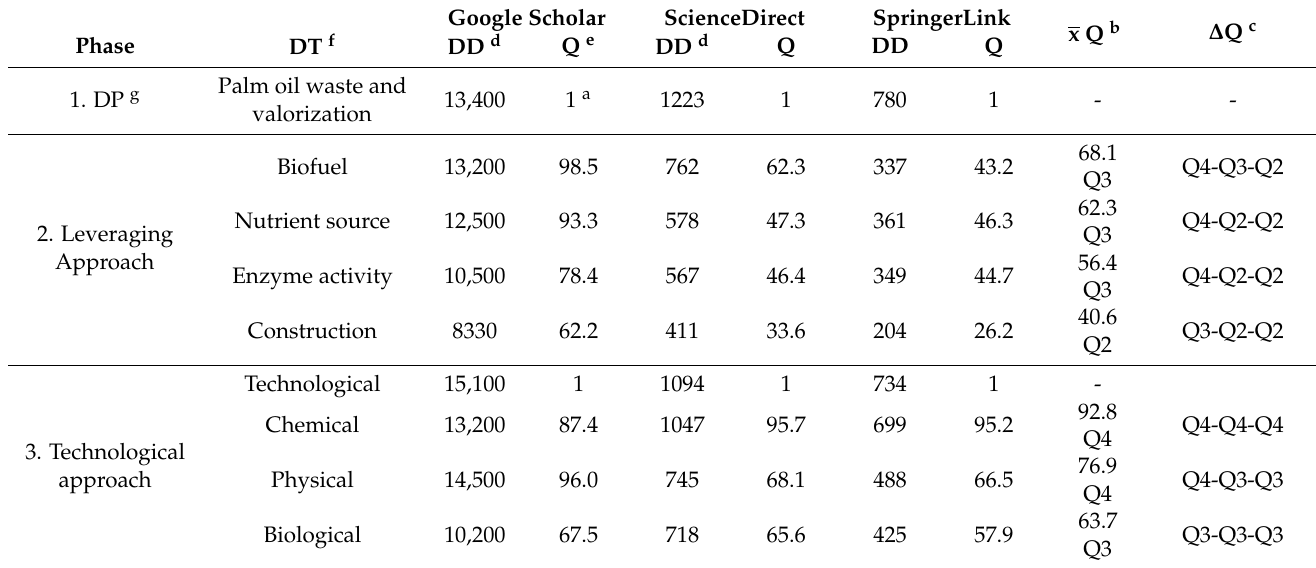
Table 1. Order of importance detected in relation to the valuation of palm oil residues and by-products worldwide in the database. Google